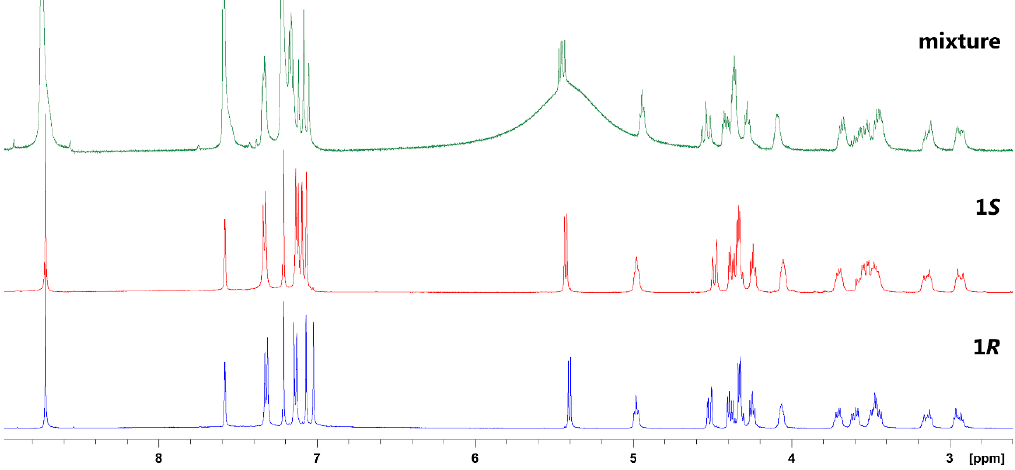
Figure 2. 1 H-NMR spectra of 1 R , 1 S , and their mixture (500 MHz, pyridine- d 5 , r.t.).